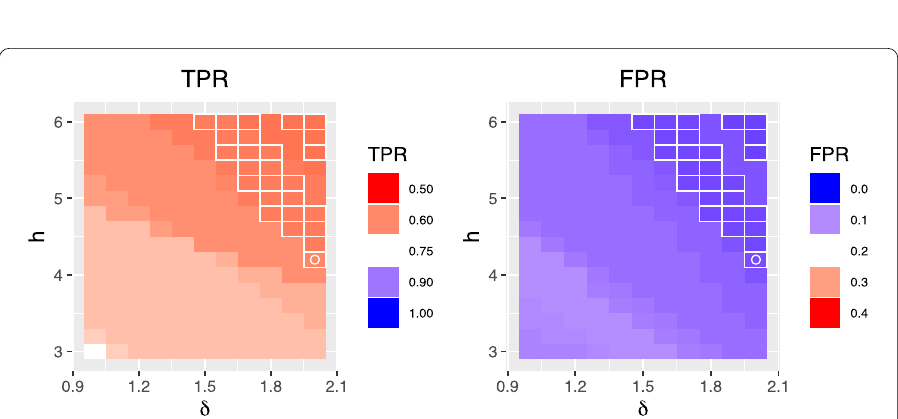
Figure 3 The proportions of ILI and positive influenza isolations. Fig. 3( a ) shows the proportion of ILI patients among outpatients. The proportion of positive influenza isolations among specimens submitted to the reference laboratories is represented in Fig. 3( b )